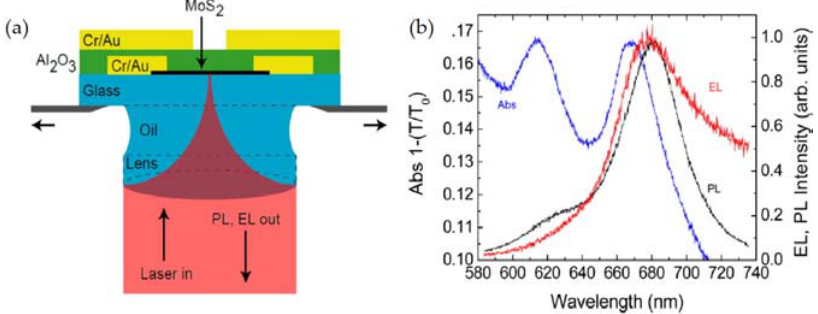
Figure 14. ( a ) Schematic of a top ‐ gated MoS 2 FET and the optical setup. ( b ) Absorption (Abs), EL, and PL spectra on the same 1L ‐ MoS 2 . Reproduced with permission from [202], American Chemical Society, 2013.